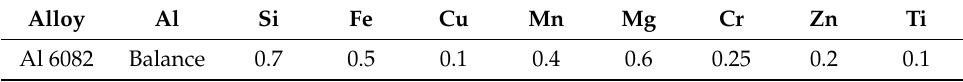
Figure 1. The experimental setup used in the present study (Bridgeport Interact 400, Connecticut, CT, USA). Table 1. Nominal composition of the alloy used in the investigation